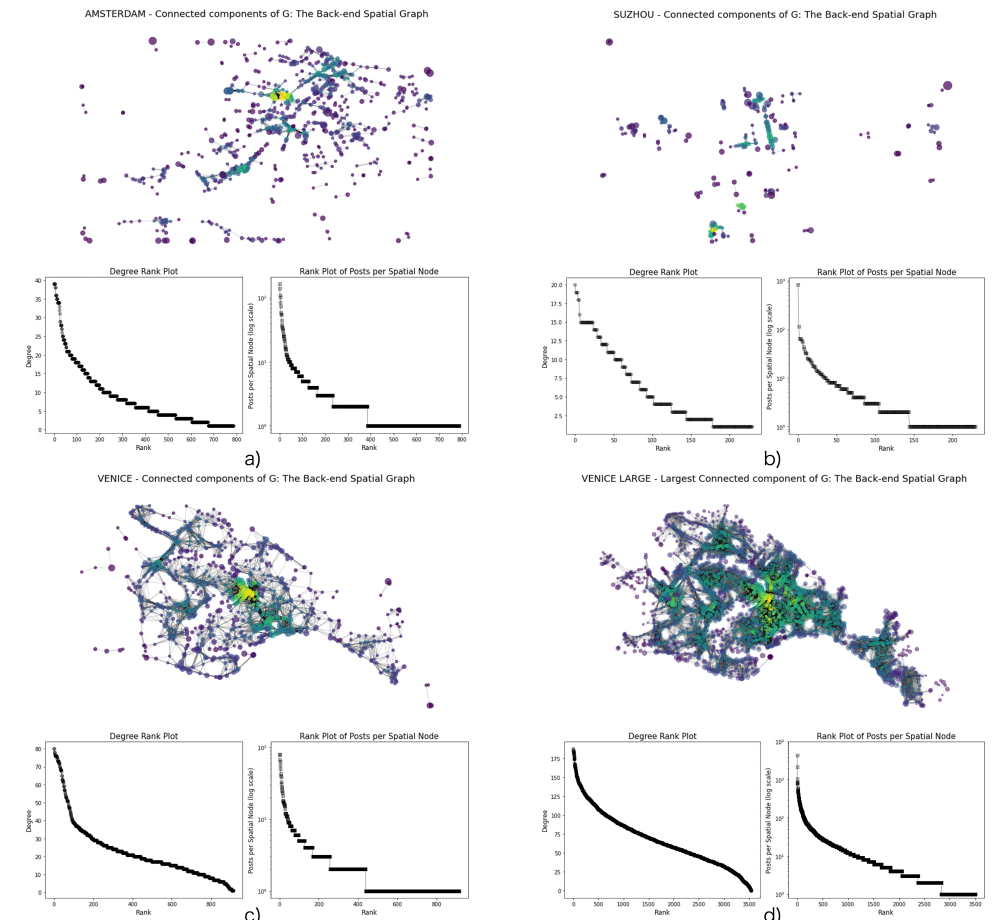
Figure 5. The back-end geographical networks for three case studies, respectively, showing the graph structure, degree ranking distribution, and the ranking distribution of posts per geo-spatial node (on a logarithm scale) in Amsterdam, Suzhou, Venice, and Venice-XL. The sizes of nodes denote the number of nearby posts allocated to the nodes, and the colors of nodes illustrate the degree of the node on the graph. Each link connects two nodes reachable to each other within 20 min.